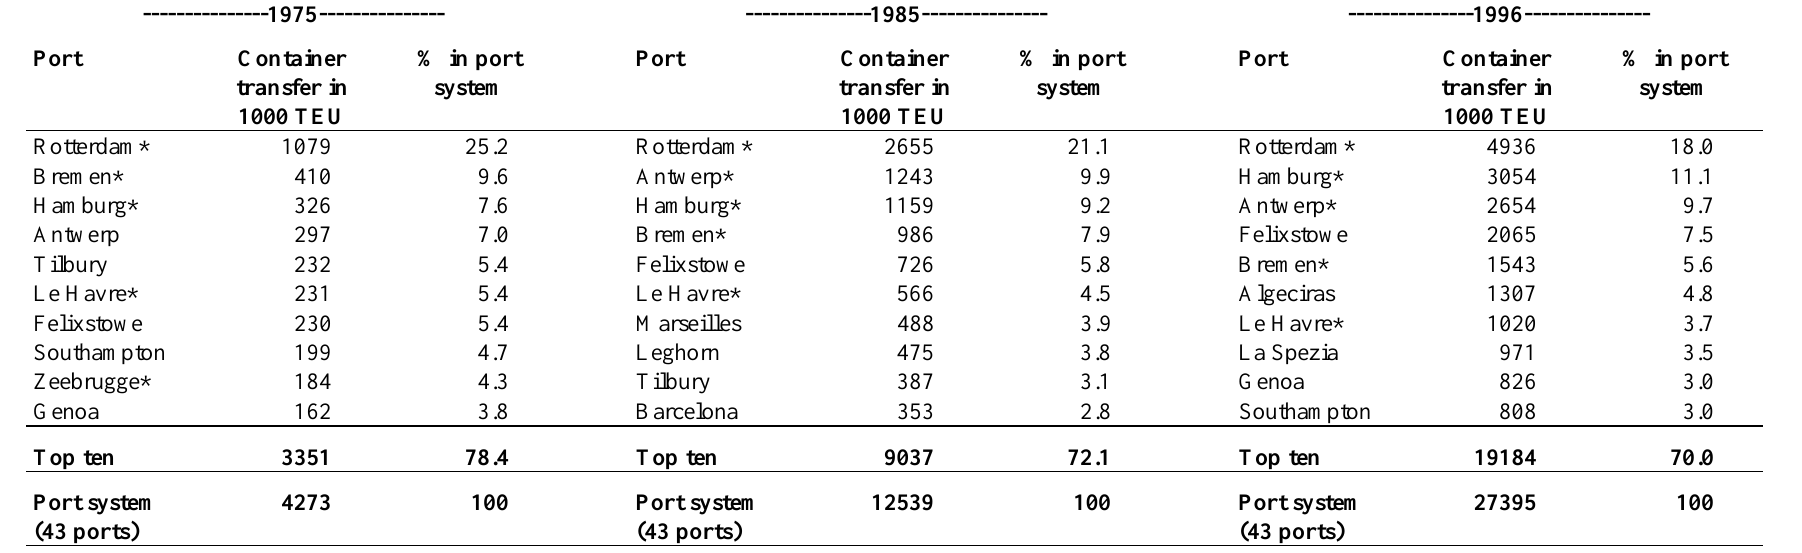
Note: * = port within the Hamburg – Le Havre